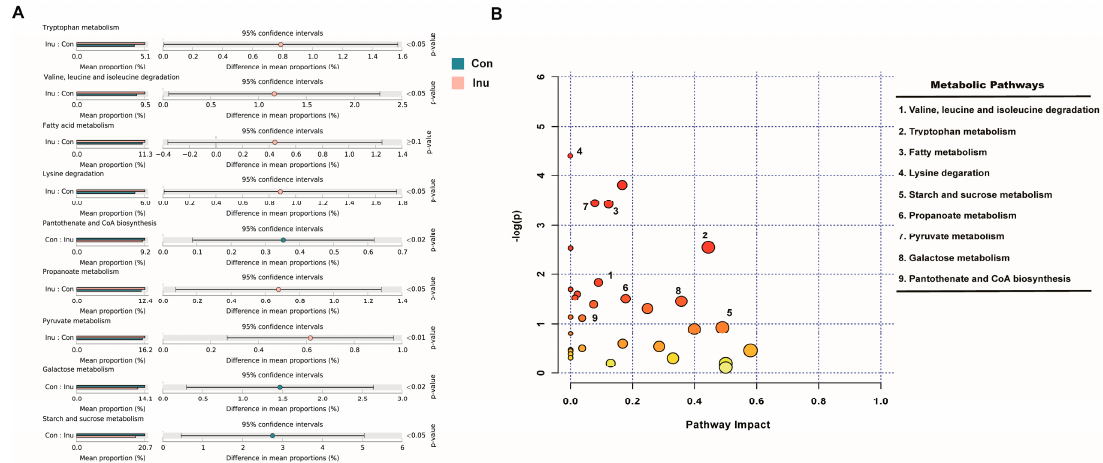
Figure 7. Common functional pathway analysis in growing pigs fed a diet with or without a 5% inulin supplement. ( A ) 16s rDNA sequencing predicted based on SILVA123 database using Tax4Fun; ( B ) significant metabolites predicted based on KEGG database using Metaboanalyst 4.0. The closer to red, the smaller p value is.